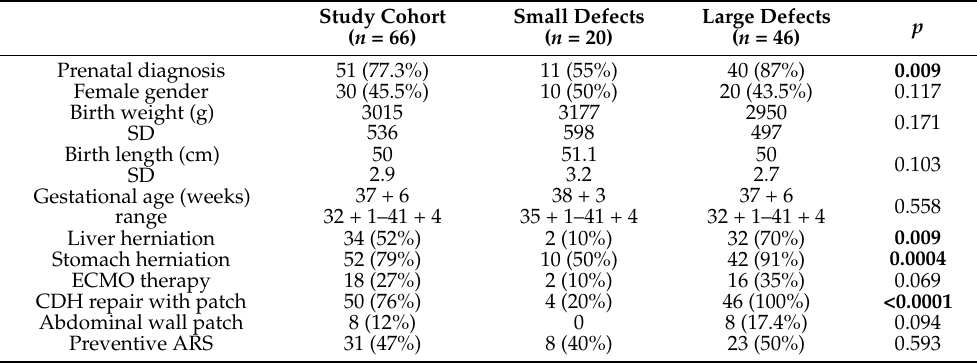
Table 1. Patient and surgical characteristics of the study-cohort.